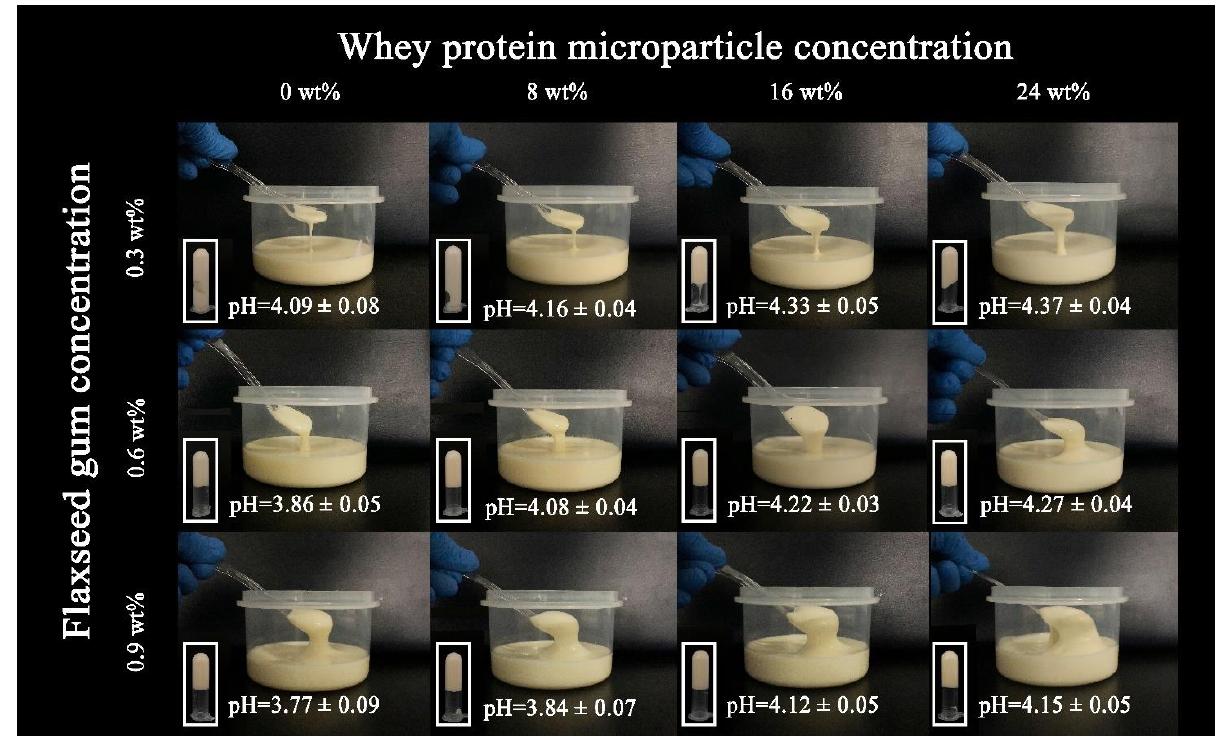
Figure 3. Photographs of model mayonnaises containing different concentrations of the flaxseed gum and whey protein microparticles.